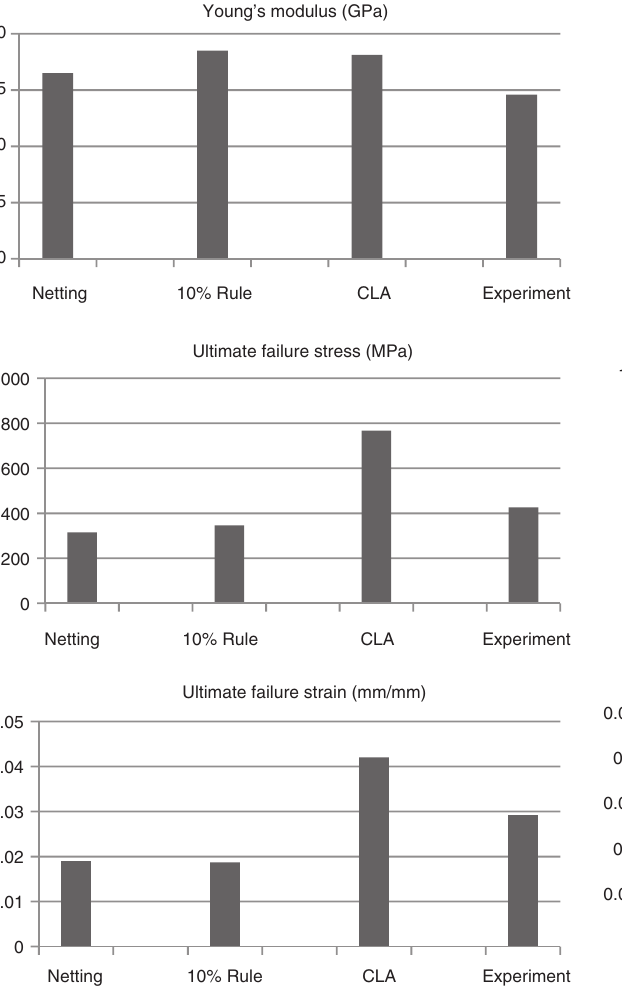
Figure 3 Summary of [+90